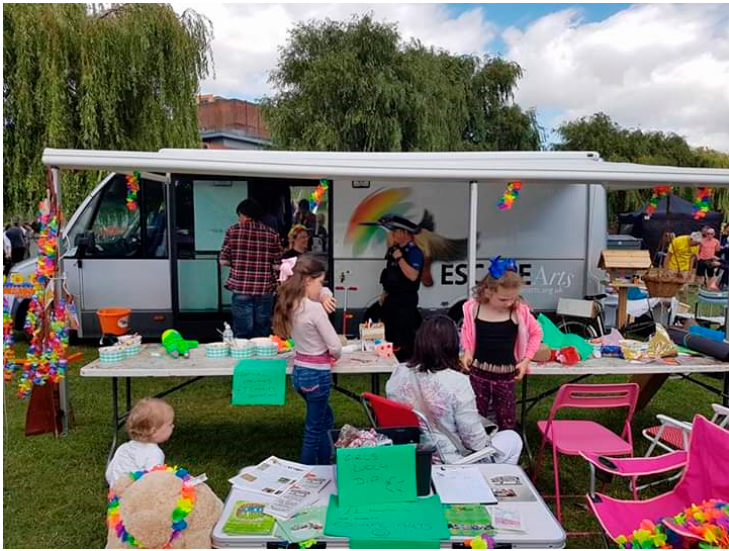
Figure 3. EA multimedia bus on the move in Warwickshire. Courtesy of